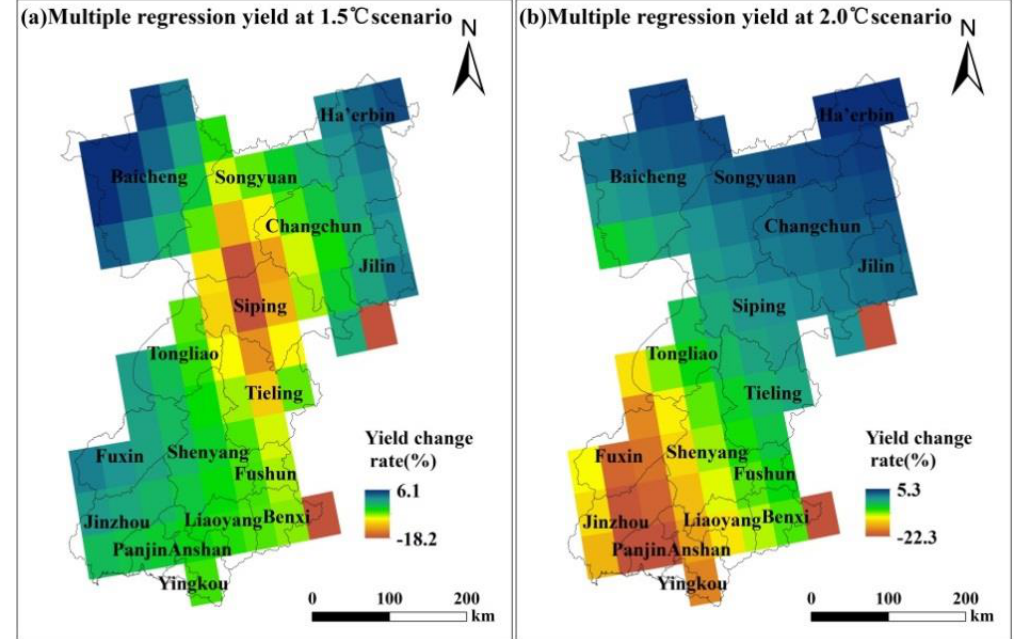
Figure 10. Distribution of the maize yield change in the Songlian Plain maize belt predicted by multiple regression under the 1.5 °C ( a ) and the 2.0 °C ( b ) global warming scenarios.